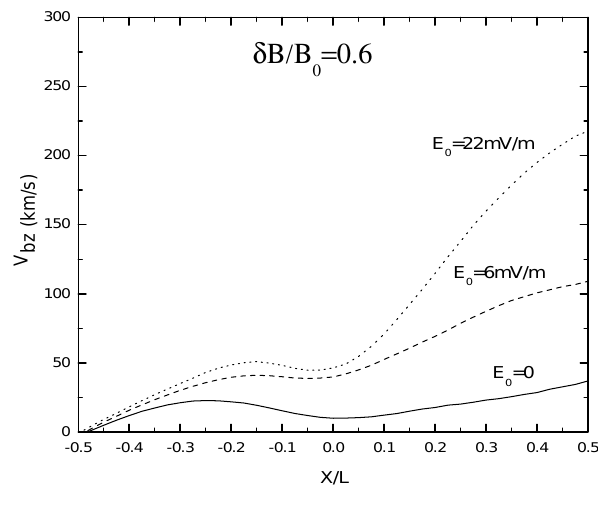
Fig. 10. Oxygen density profiles for different values of the electric field (as indicated). Dimensionless units.